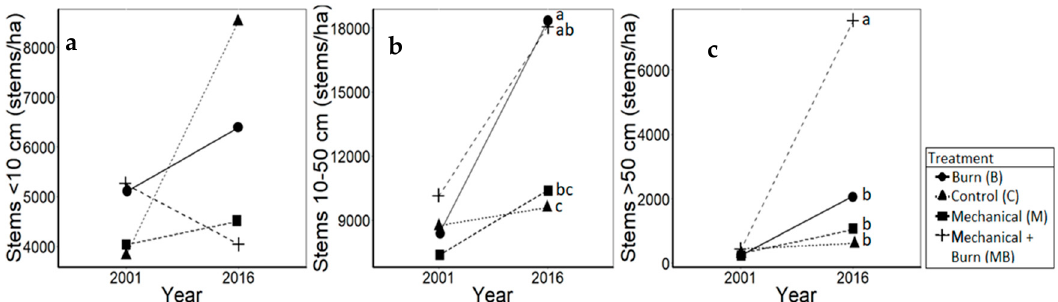
Figure 3. Oak stems ( a ) < 10 cm, ( b ) 10–50 cm, and ( c ) > 50 cm results showing the 4 treatment e ff ects